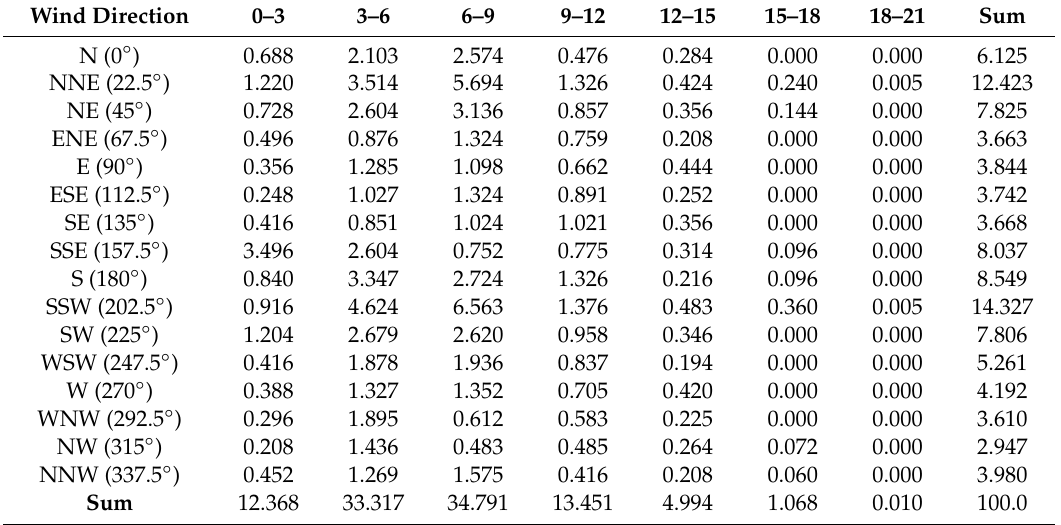
Table 1. 1 Relative frequency of mean wind speed and direction